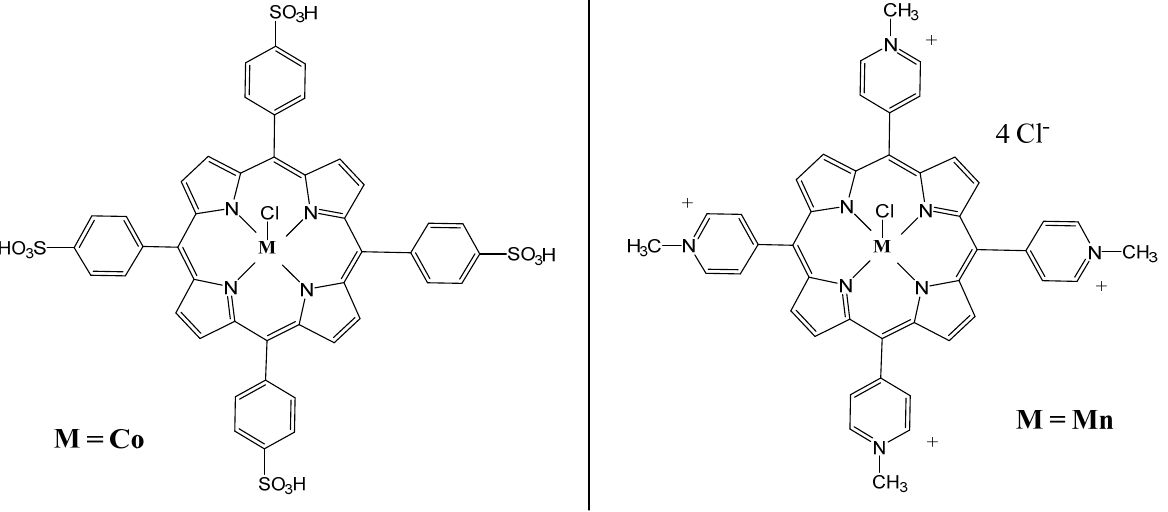
Figure 5. Chemical structures of two metalloporphyrins: CoTPPS and MnTMPyPCl 5 [54].